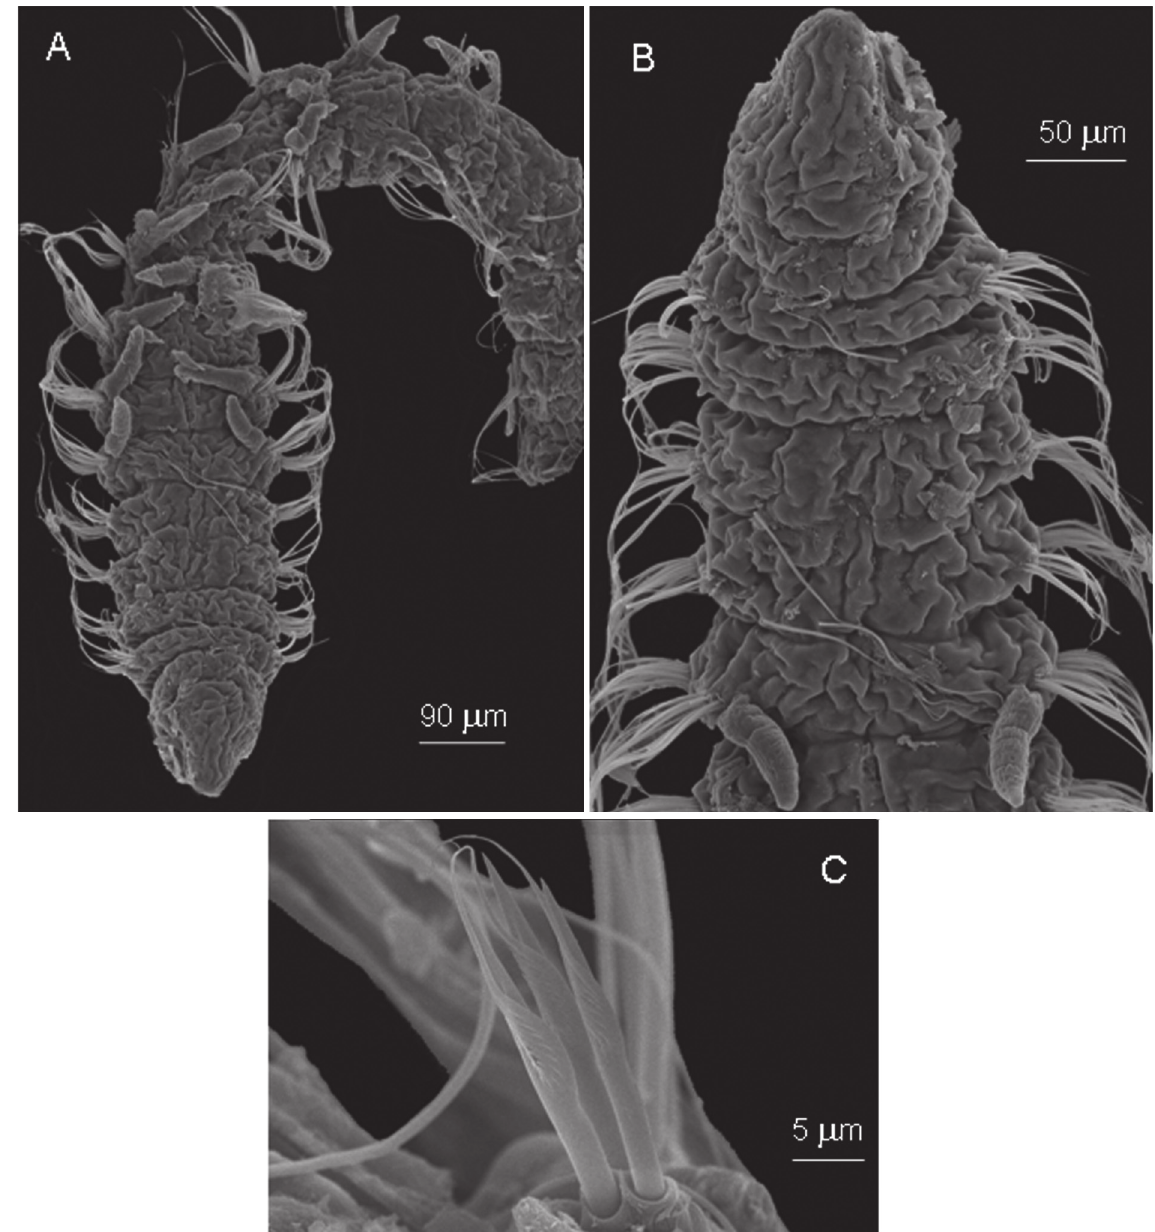
Fig . 11. – Paradoneis bathyilvana n. sp.: A, dorsal view; b, anterior region, dorsal view; c, lyriform dorsal modified chaetae, posterior chaetiger. Scale bar: A 90 µ m; b 50 µ m; c 5 µ